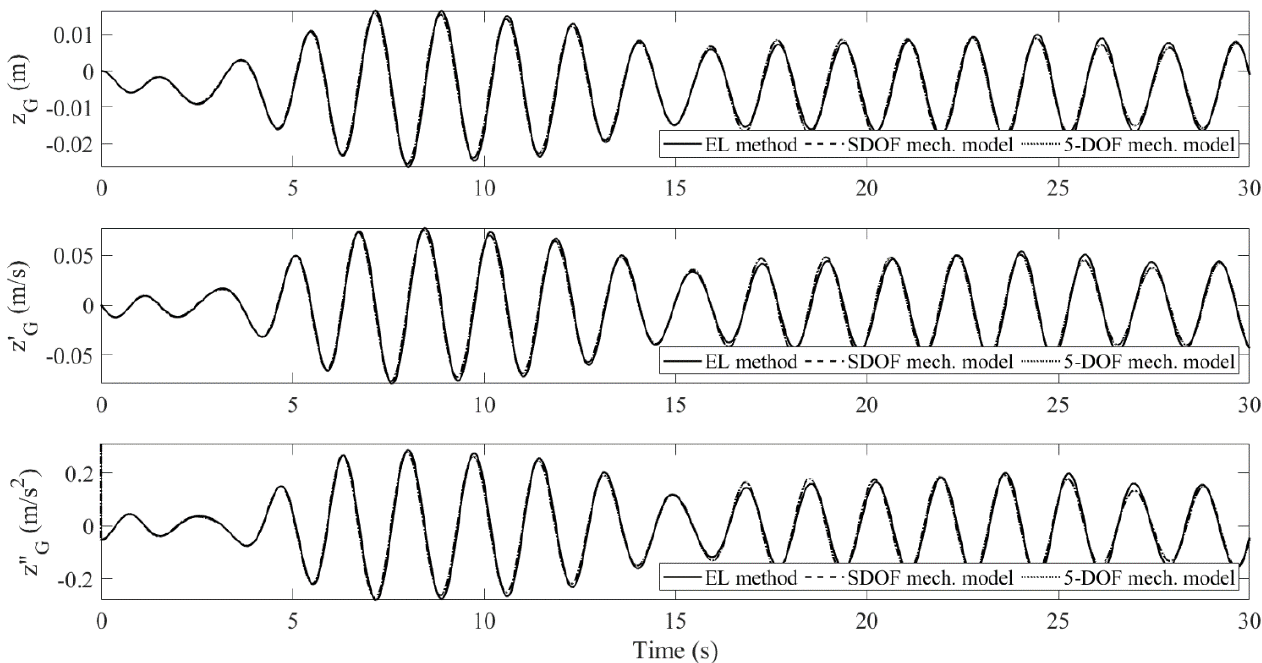
Figure 15. The horizontal forces acting on the floating body for the small-wave case.